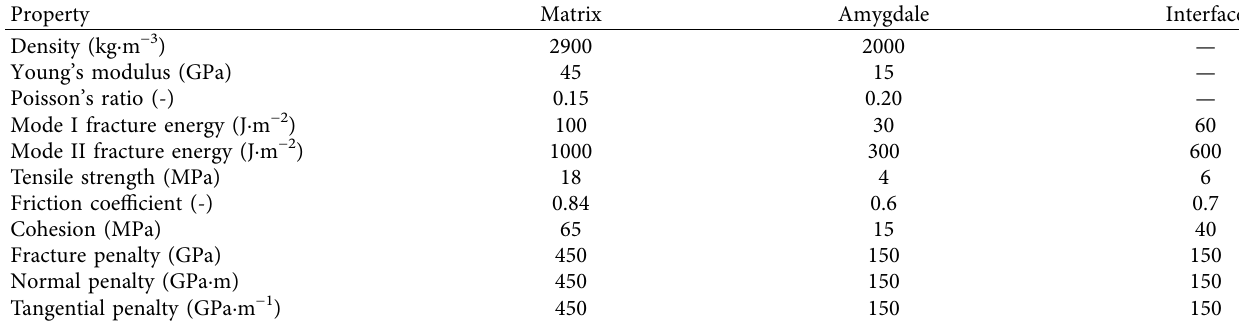
Table 1: Mesoparameters of this Irazu-HM.